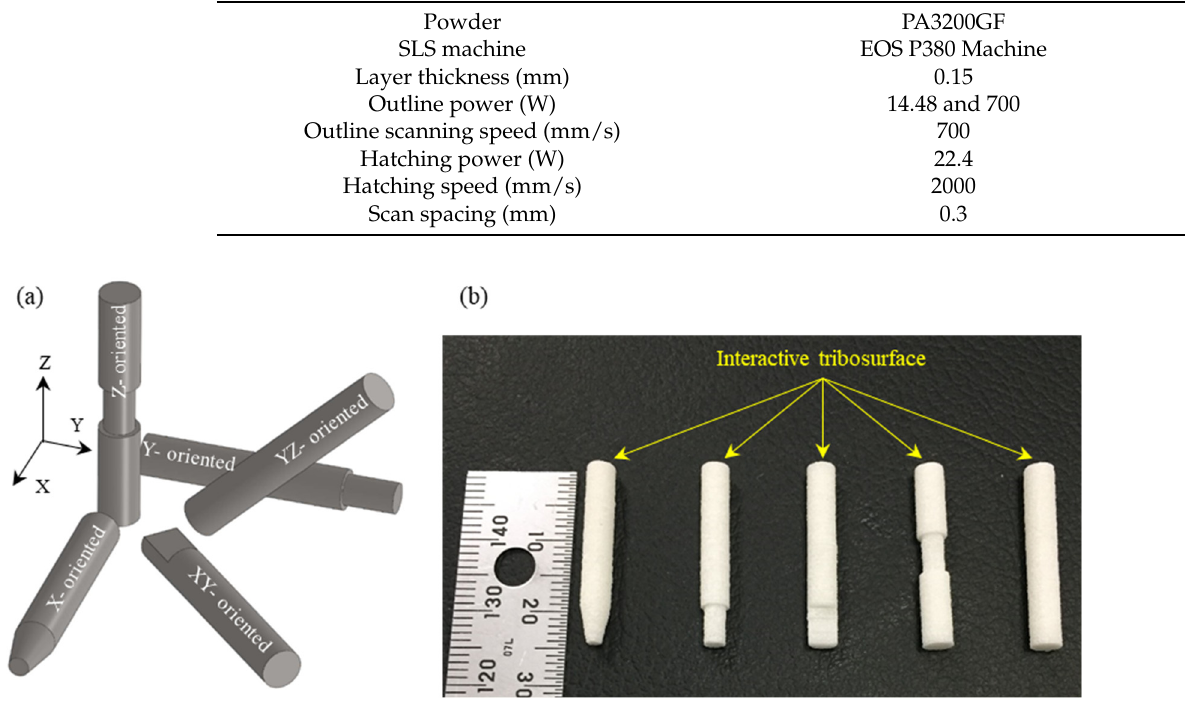
Figure 1. ( a ) Schematics of specimens’ orientation in the SLS build chamber; ( b ) fabricated SLS specimens, PA3200GF. Table 1. SLS of PA 3200 GF test specimens.